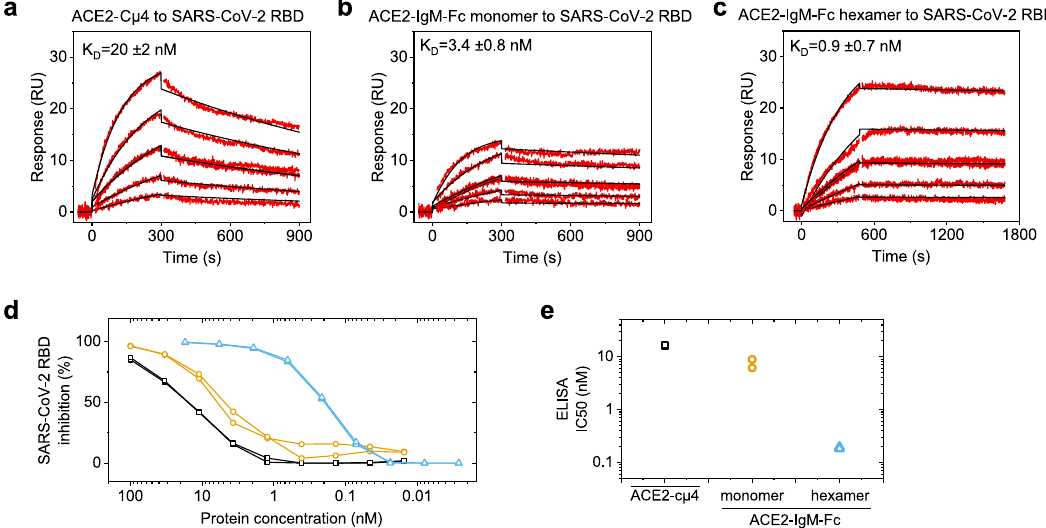
Fig. 3 Antigen-binding properties of the ACE2-fusions. a – c Representative sensorgrams from SPR experiments for the binding of the ACE2-fusions to immobilized SARS-CoV-2 RBD on CM5 chips. Different concentrations of the ACE2-fusions were injected. The data were fi t to a 1:1 binding model to obtain apparent dissociation constants. The dissociation constants are mean values of triplicates with standard deviations. d Binding of the ACE2-fusions to RBD determined by ELISA and the corresponding IC50s ( n = 2). The lines are guide for the eyes. ACE2-C µ 4 (black squares), ACE2-IgM-Fc monomer (yellow circles), ACE2-IgM-Fc hexamer (blue triangles). e IC50 values ( n = 2) from the fi ts to the ELISA